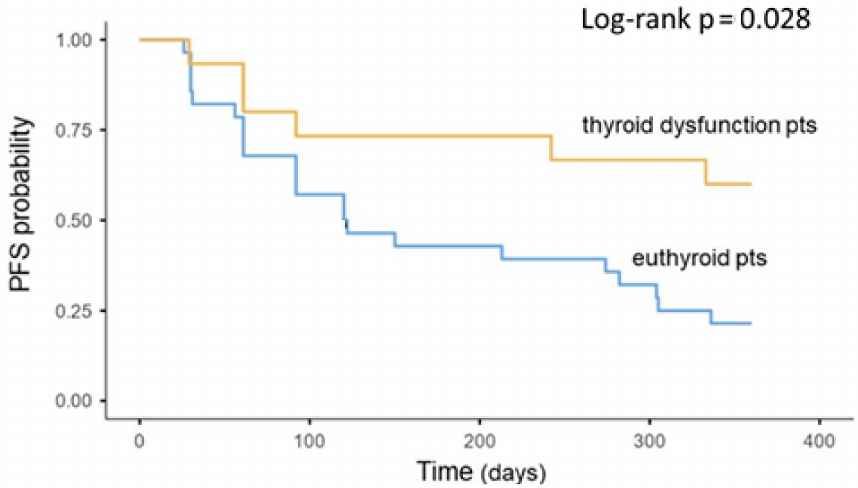
Figure 1. Association between thyroid dysfunction during treatment and oncologic outcomes. Kaplan–Meier plots of progression-free survival. IrAEs = immune-related adverse events; PFS = progression-free survival; pts =